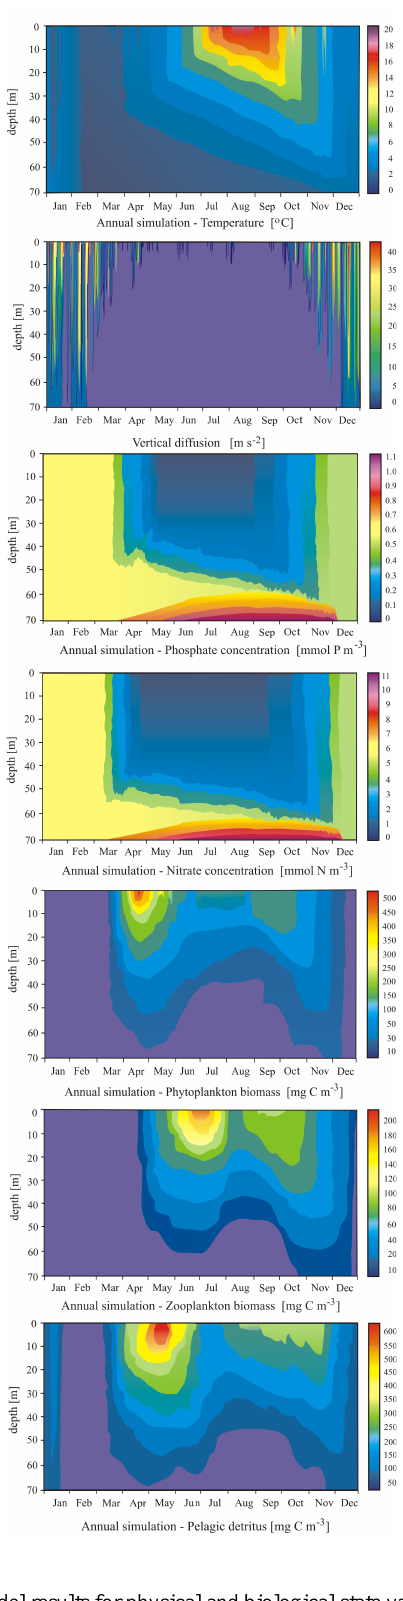
Fig. 4. Model results for physical and biological state